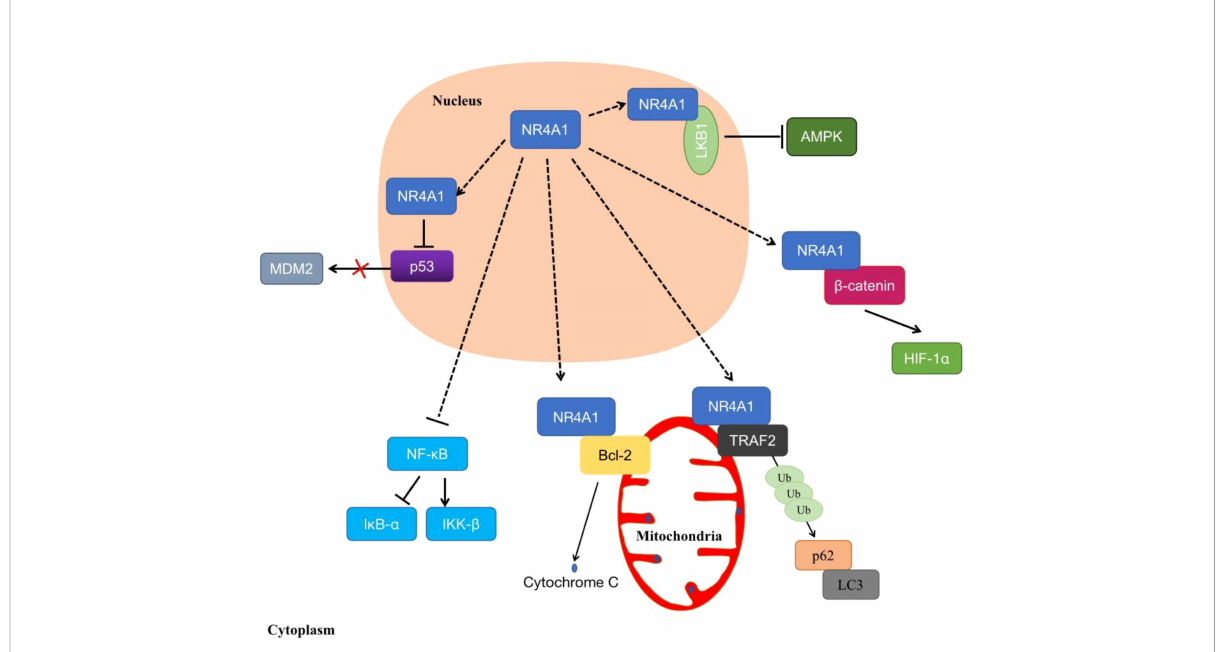
FIGURE 4 The non-genomic regulations of NR4A1. NR4A1 can affect kinds of biological processes through binding to LKB1, b -catenin, Bcl-2, MDM2, TRAF2, or blocking NF- k